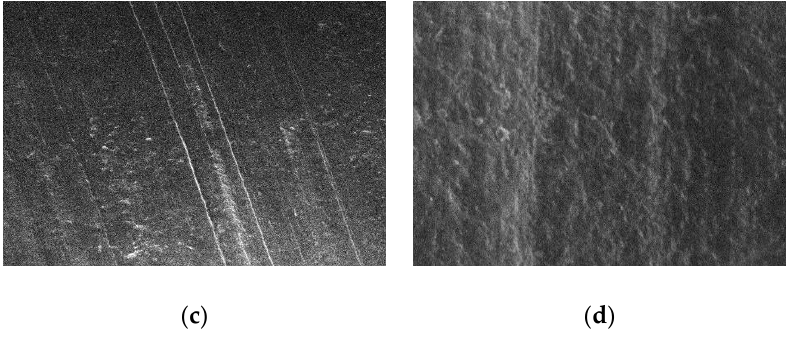
Figure 9. SEM image of fiber sheath. ( a ) 0 d TPEE; ( b ) 24 d TPEE; ( c ) 0 d PTFE; and ( d ) 24 d PTFE.